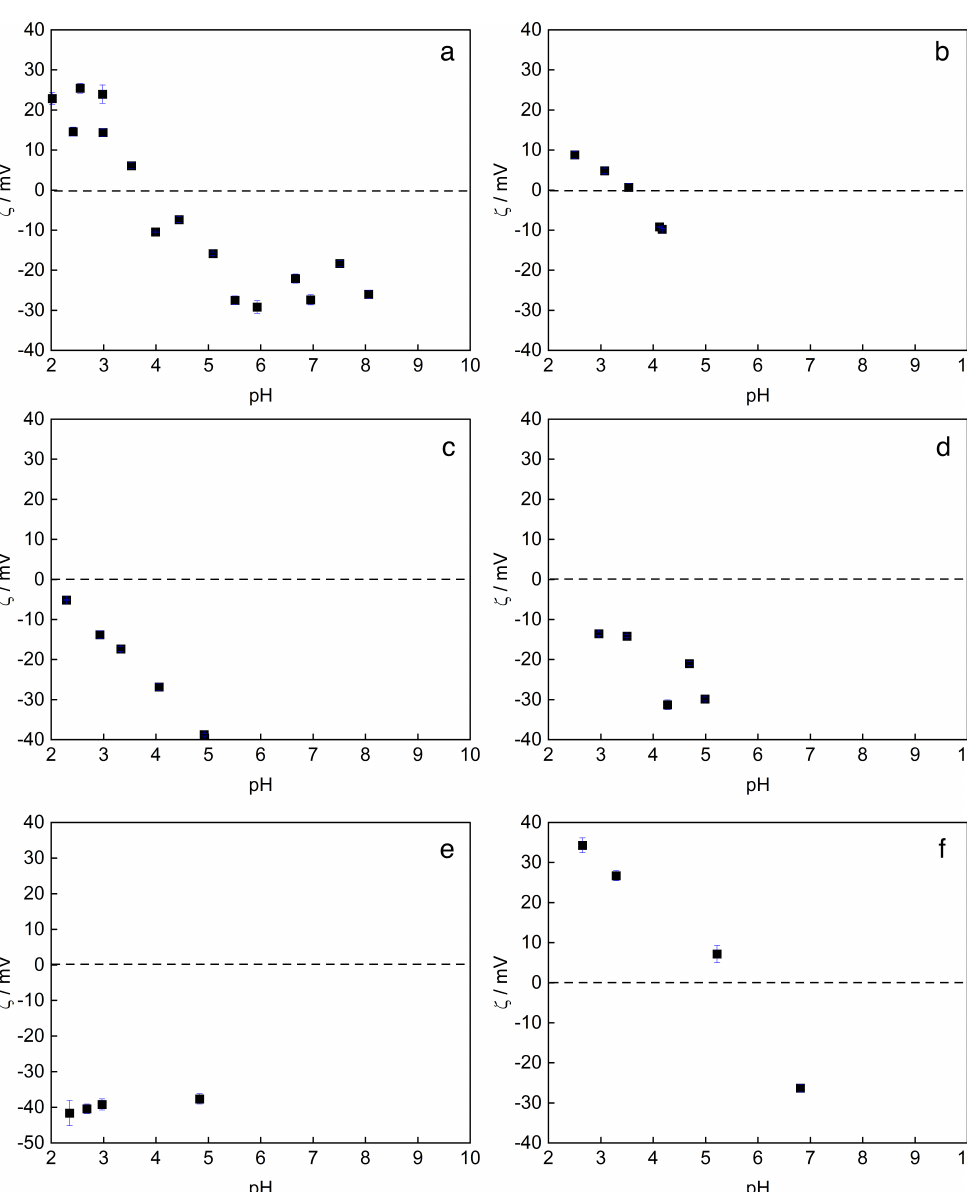
Figure 4. Experimental electrokinetic ( ζ ) potential measured at constant ionic strength I = 10 − 2 molL − 1 using the laser doppler microelectrophoretic